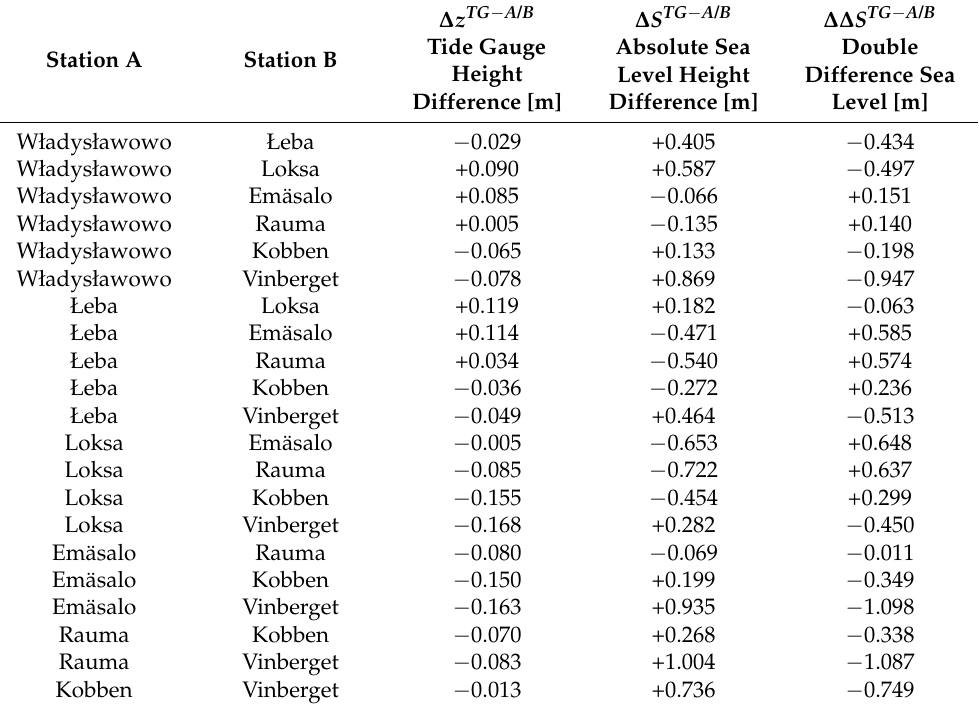
Table 14. Relative (baseline) height differences between ECR stations A and B and between co-located TG stations A and B and differences of baseline height differences. TG height differences and ECR height differences transferred to the TG reference markers are computed with the equation